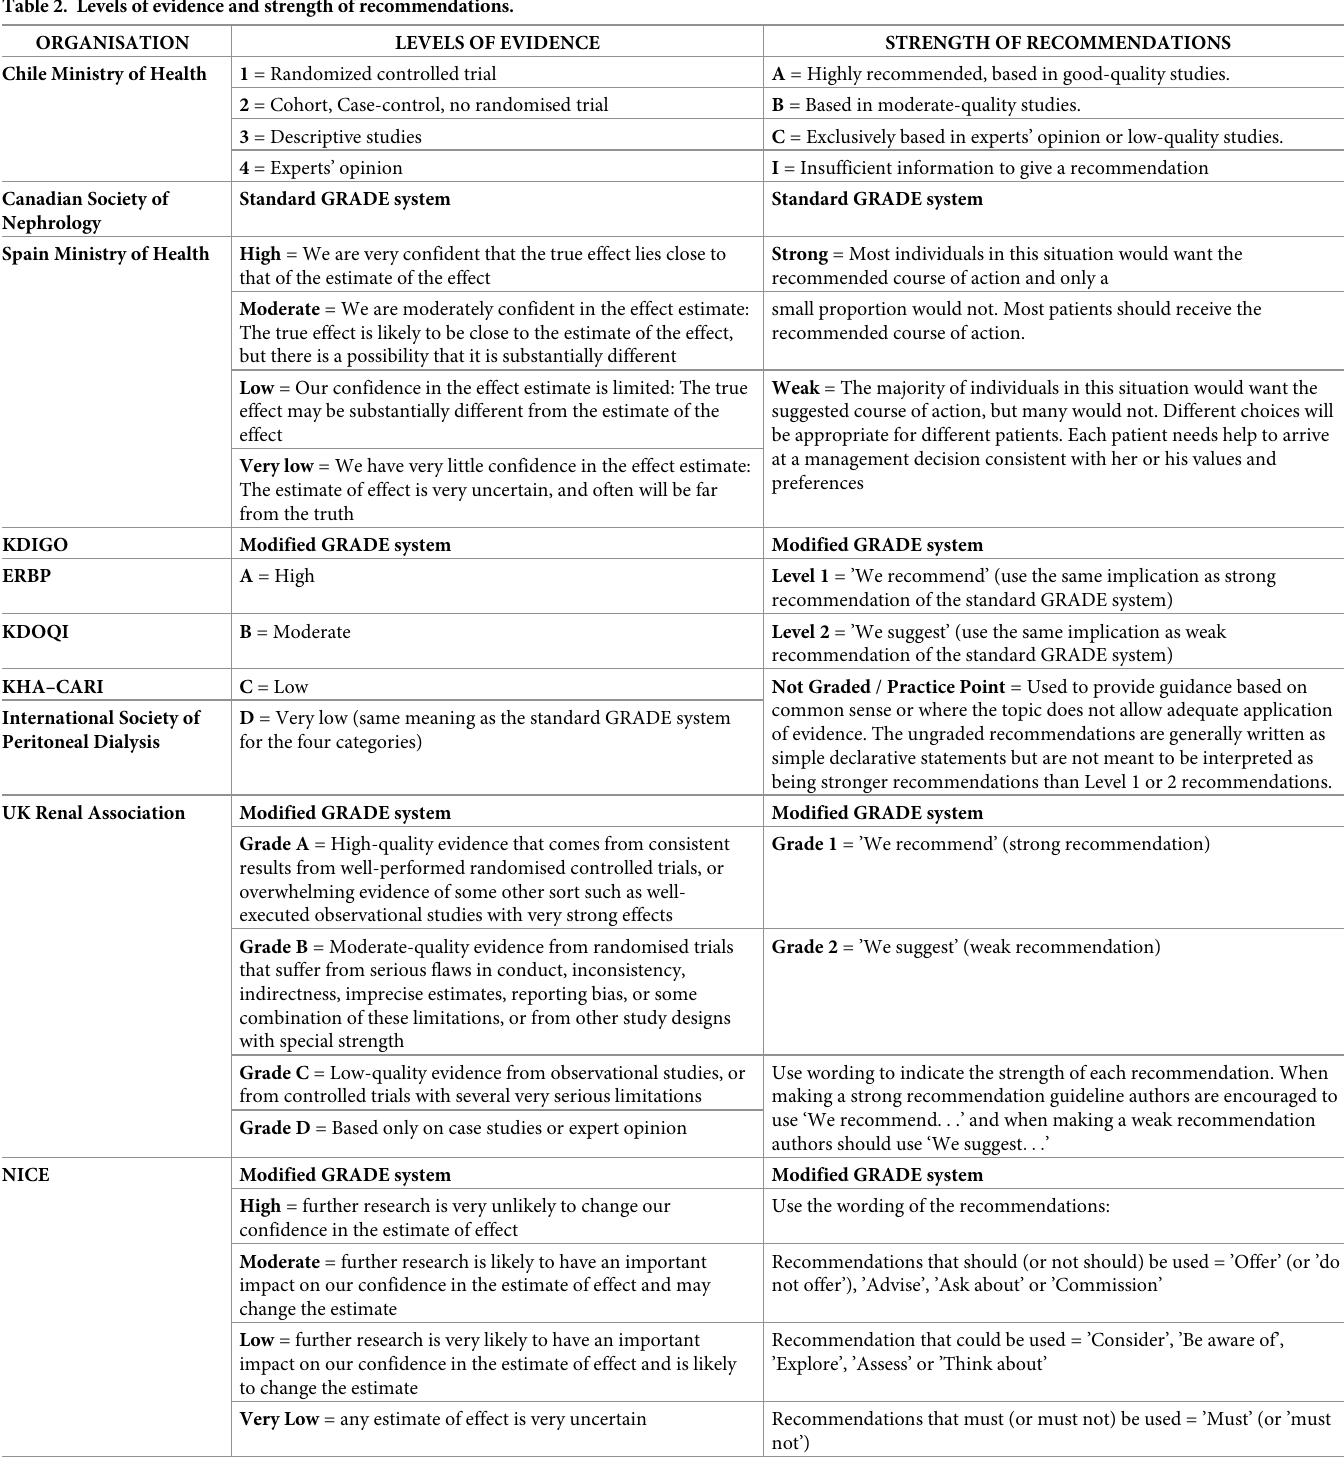
Table 2. Levels of evidence and strength of